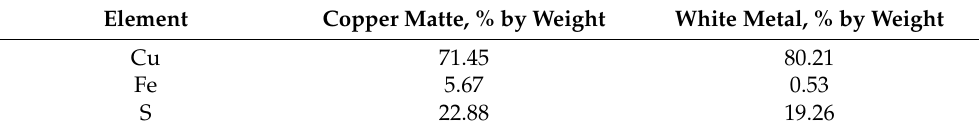
Table 2. Chemical composition of copper matte and white metal used during conversion tests. Element Copper Matte, % by Weight White Metal, % by Weight Cu 71.45 80.21 Fe